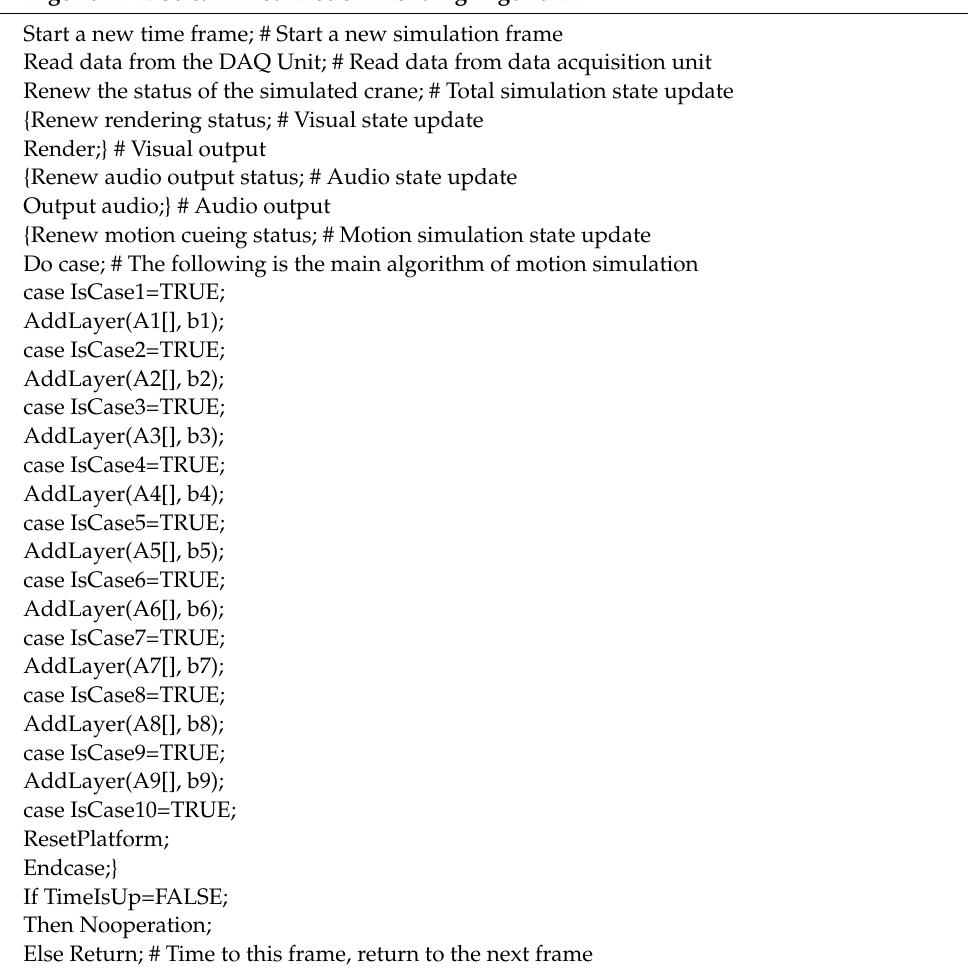
Algorithm 1. Streamlined Motion Blending